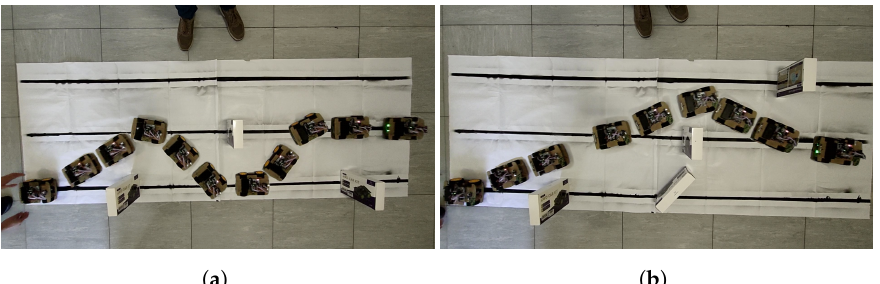
Figure 7. Path route performed with the WMR in real-time on hardware (as explained in Section 2.1). ( a ) Photo sequence of zig-zagging maneuver. ( b ) Photo sequence of the double lane change